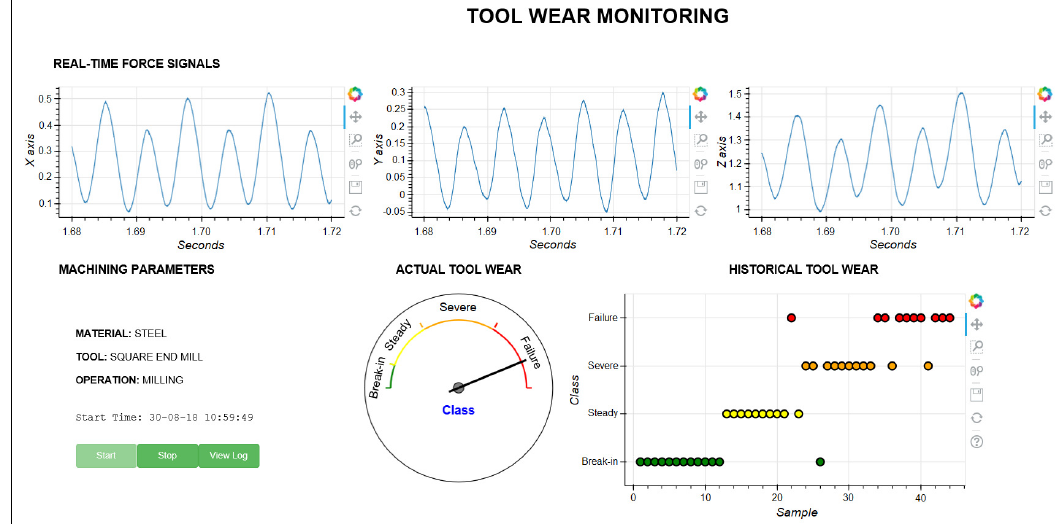
Figure 4. The tool wear monitoring dashboard displayed by the GUI module. The top part displays the real-time forces on the three axes, and the bottom part contains machining parameters and associated information, a gauge with the actual tool wear level and a history of the tool wear